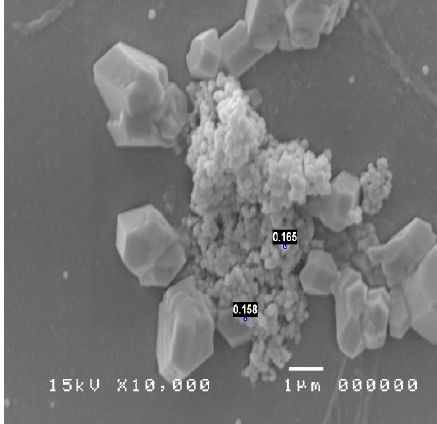
Figure 5. SEM image showing a colony of mycoplasma in colony caught in crystals (image enlargement 10,000 × ).